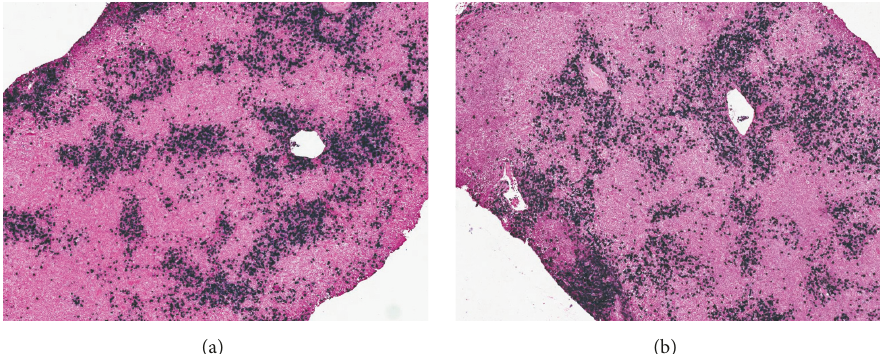
Figure 3: Kappa (a) and lambda (b) mRNA by in situ hybridization (showing polytypic plasma cells) from submandibular gland/lymph node